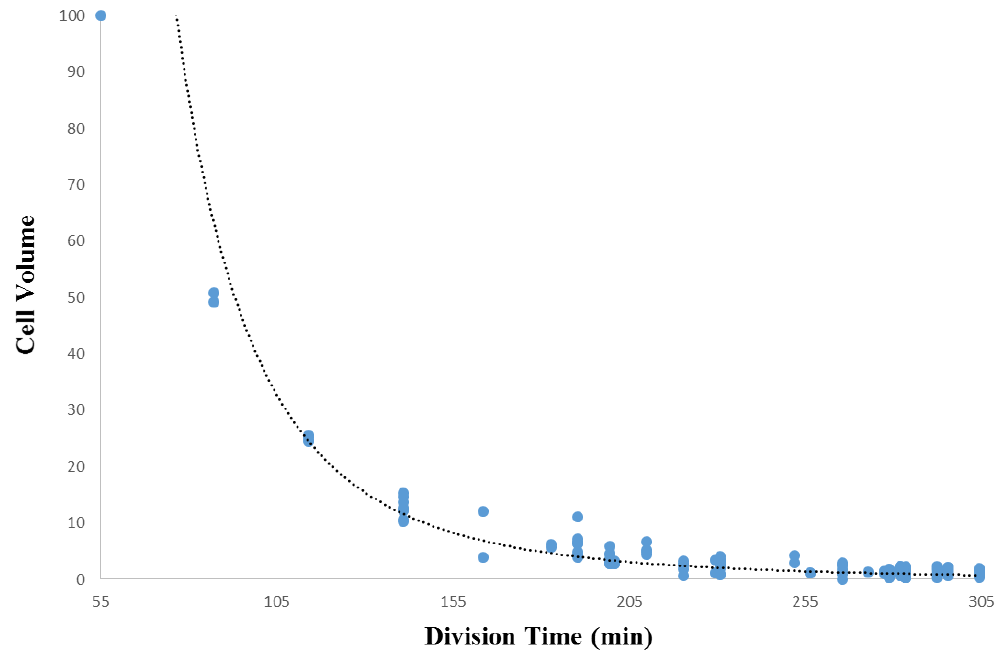
Figure 5. An analysis of cell volume versus lifetime in Ciona , based on all cells between the one-cell stage and the 112-cell stage (N = 224). Cell volume is normalized as a percentage of total embryo volume, and lifetime is the duration of the period of time between a cell’s creation via division and its division into two daughter cells. Trendline (black) is based on a power function.